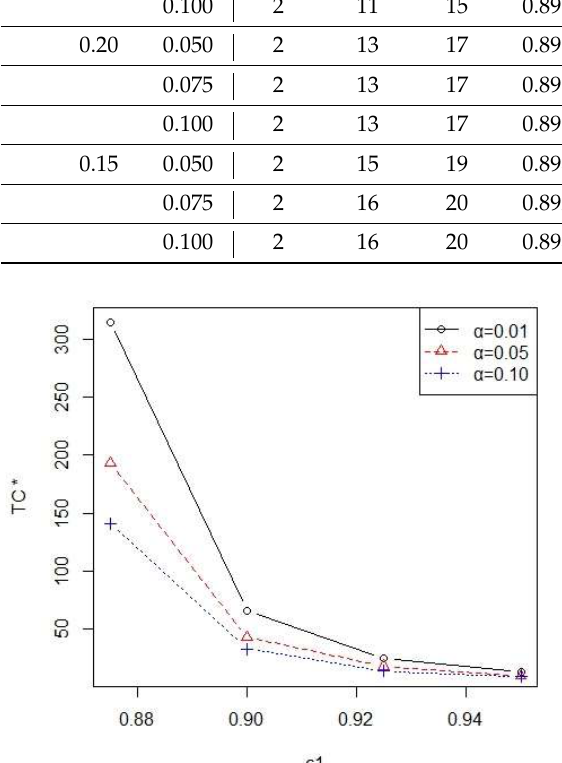
Figure 4. Minimum total cost curve for 1-β = 0.75, 0.80, 0.85 at α = 0.1 and p = 0.05.